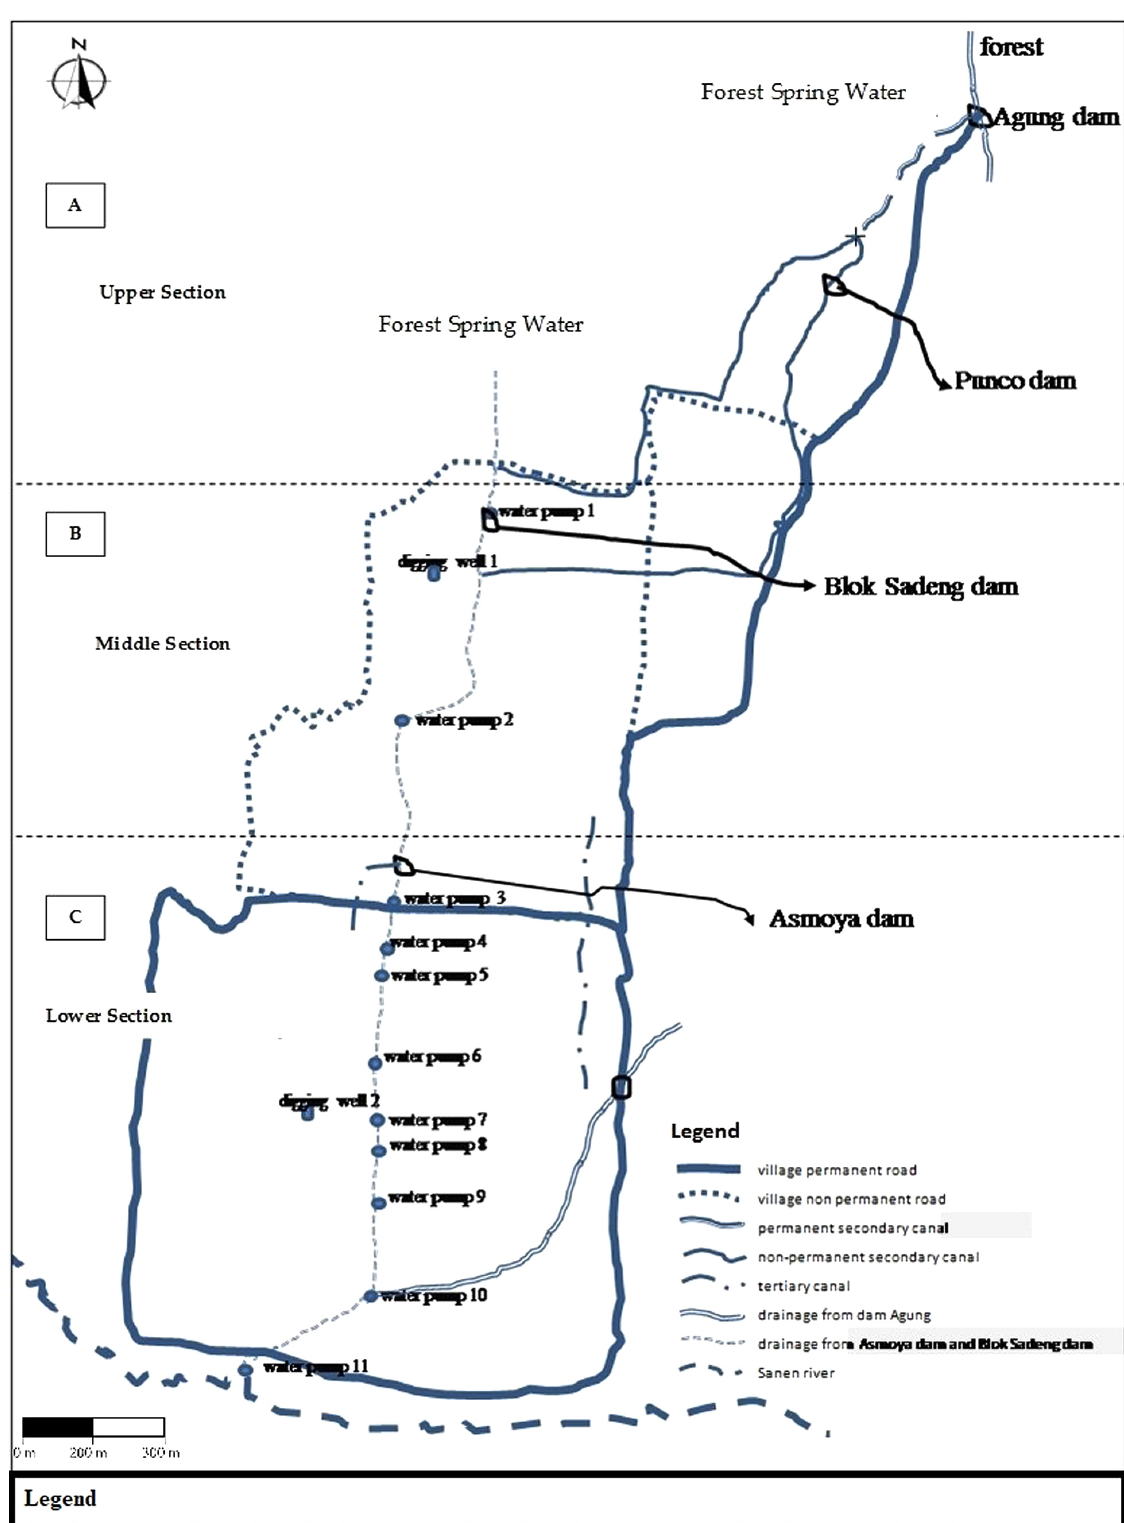
Fig. 2. The scheme of the studied irrigation